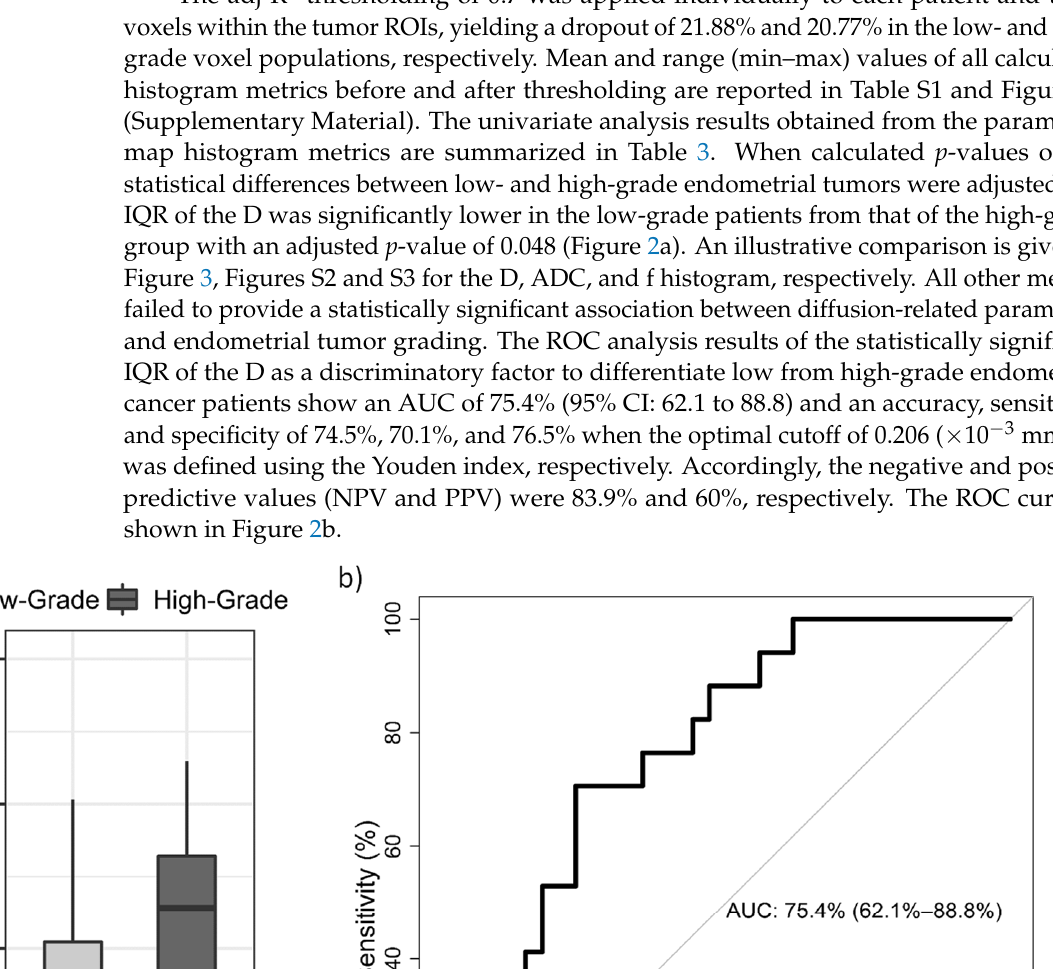
Figure 3. ( a , b ) Single DWI slice superimposed with a parametric map of D depicting ROI from a high- and a low-grade patient, respectively. ( c ) Whole-tumor histograms obtained from the low- grade patient (blue color) and the high-grade patient (red color). An illustrative representation of the reported statistical analysis results is depicted in ( c ), showing a significant difference in terms of the IQR value between the two histograms (a higher IQR in the IVIM-D histogram in high-grade compared to low-grade patients).